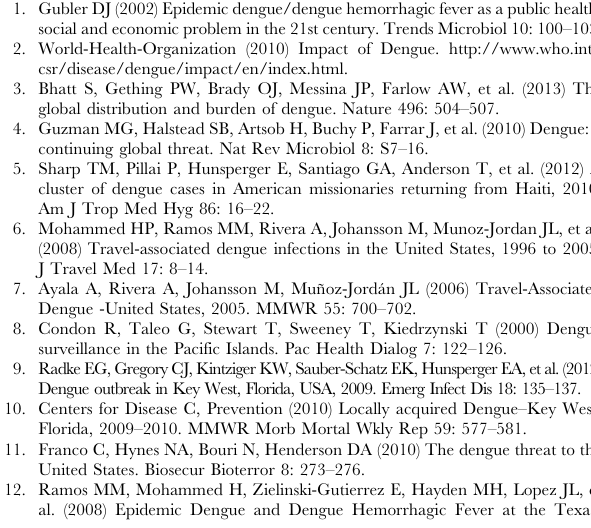
Figure S1 Assay performance in fresh vs. frozen samples. Moderate (black circle) and low (black square) positive concentra- tions of laboratory-adapted DENV strains diluted in serum were frozen at 2 80 u C for 24 hrs and subject to five consecutive freeze/ thaw cycles. Detection measurements are shown in CT values and